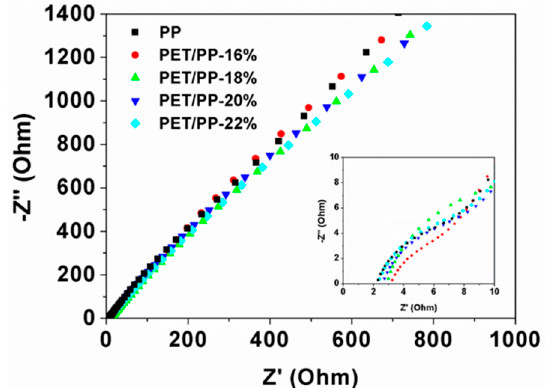
Figure 4. The AC impedance spectra of symmetric cells SS/separator/SS with PP separator and the PET/PP separators.